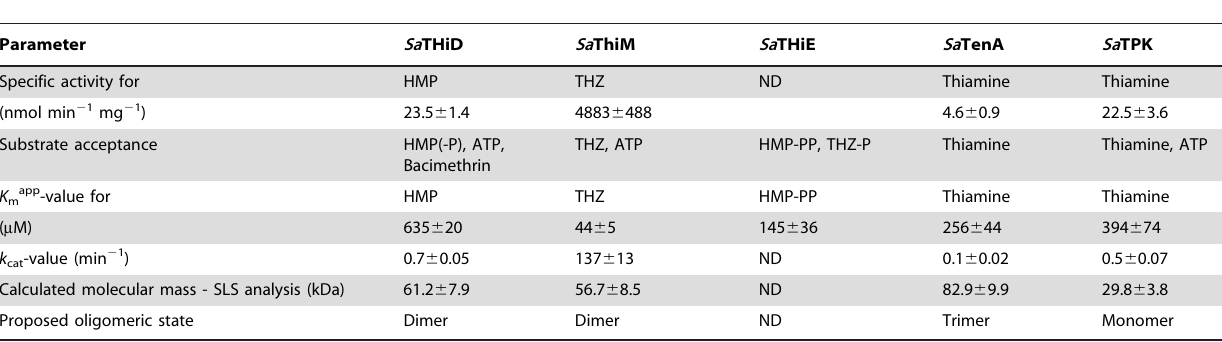
Table 1. Kinetic properties of the S. aureus